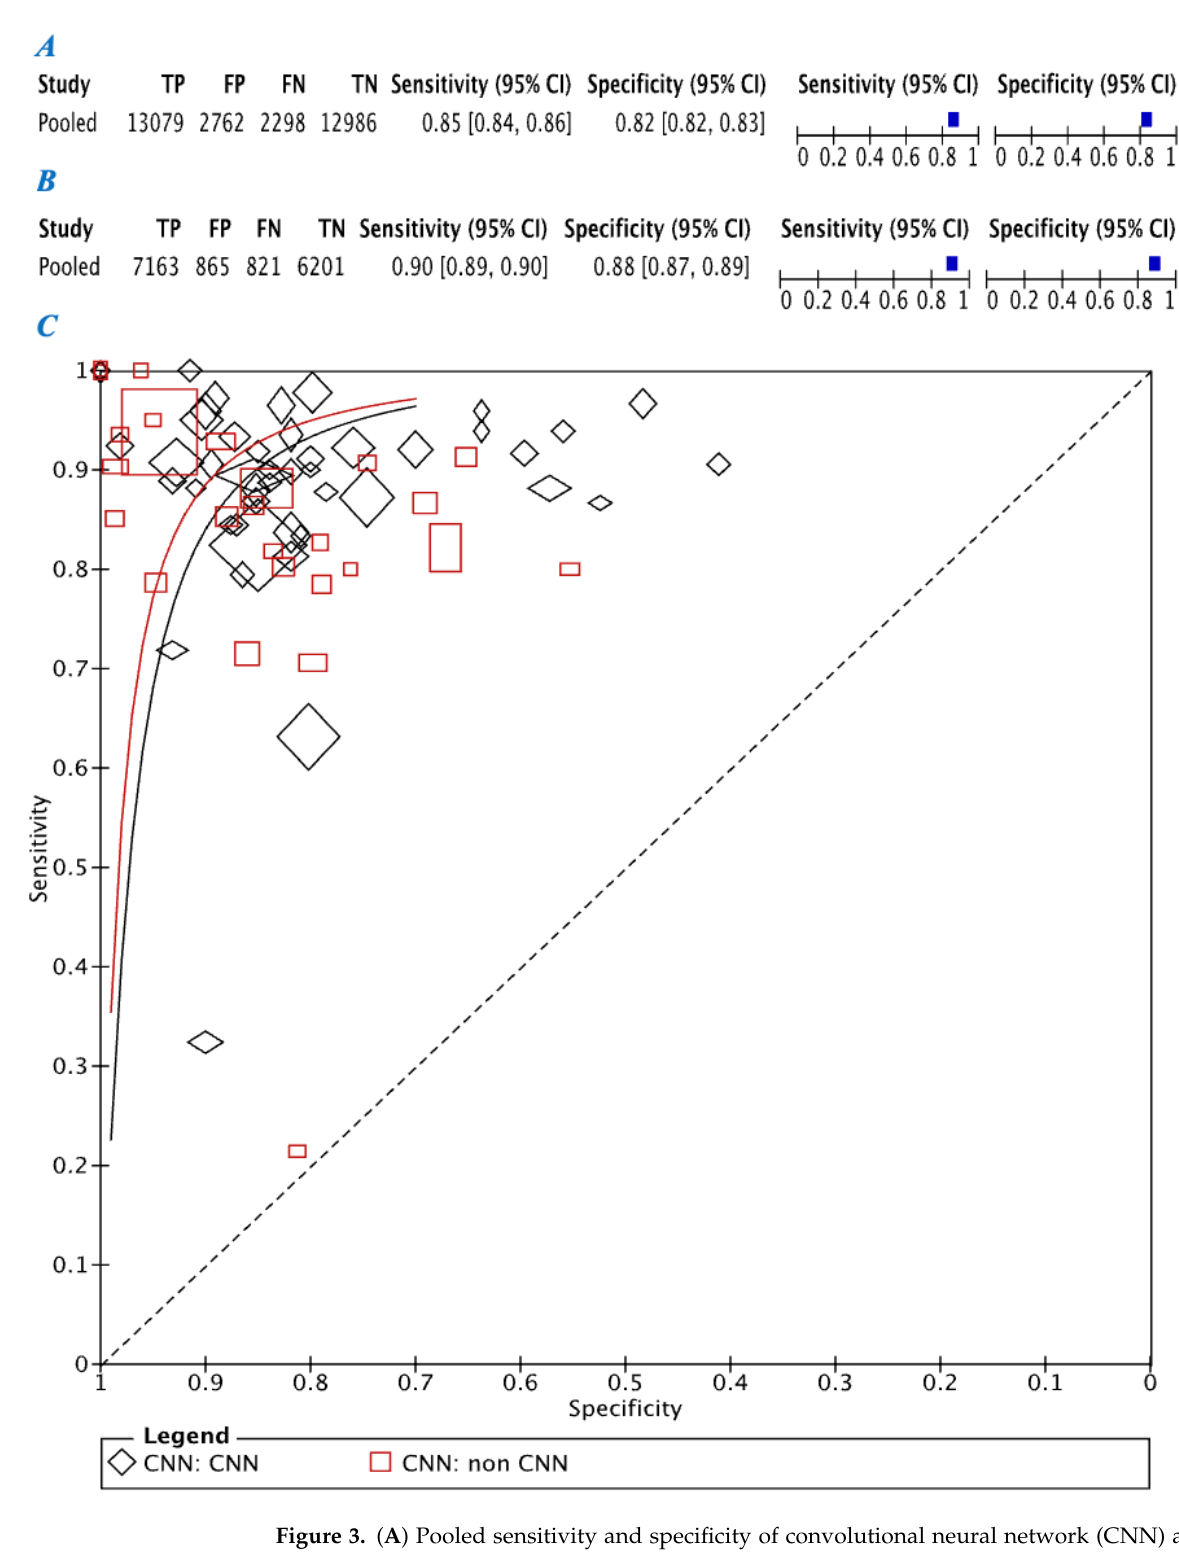
Figure 3. ( A ) Pooled sensitivity and specificity of convolutional neural network (CNN) analyses and ( B ) represents pooled sensitivity and specificity of non-CNN analyses. ( C ) Depicts the receiver operating characteristic (ROC) curve for CNN analyses (black) versus non-CNN analyses (red).